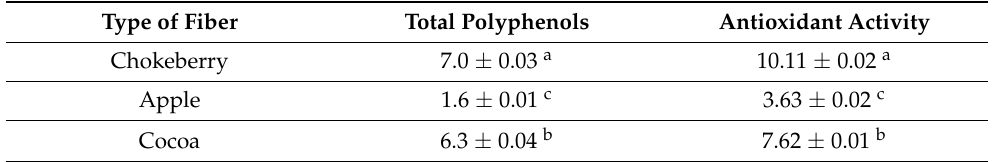
Table 4. Content of total polyphenols (mg GAE/1 g d.m.) and antioxidant properties (mmol Trolox/100 g d.m.) in the studied fiber